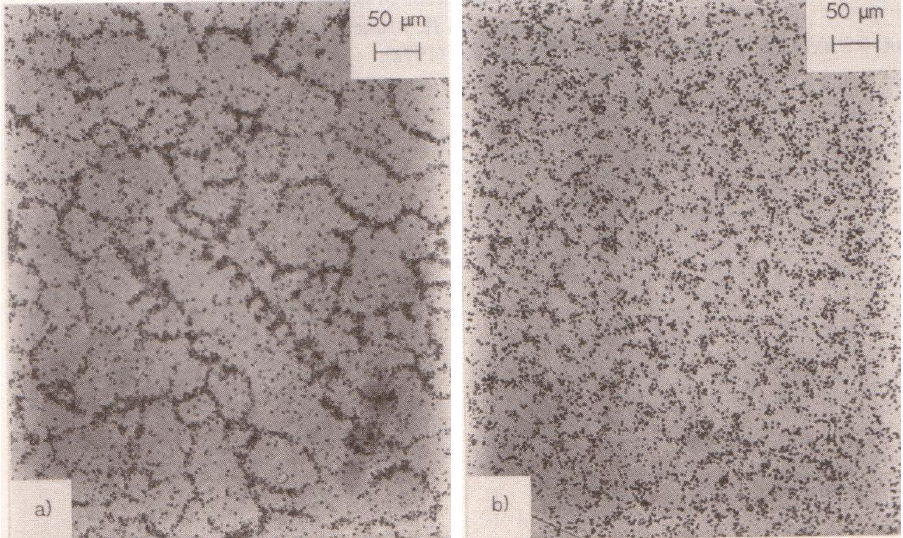
Figure 10. Microstructures of a dilute Ni B alloy solidified from a melt undercooled by 99 1 60 K ( left ) and solidified upon an undercooling of 300 K ( right ). The microstructures have been received by neutron autoradiography technique that is extremely sensitive for boron detection. The distribution of boron is visible by the dark regions while nickel-rich regions appear bright. The left microstructure shows strong segregation of boron in the interdendritic regions while the right microstructure shows more or less homogeneous distribution of boron over the entire cross section